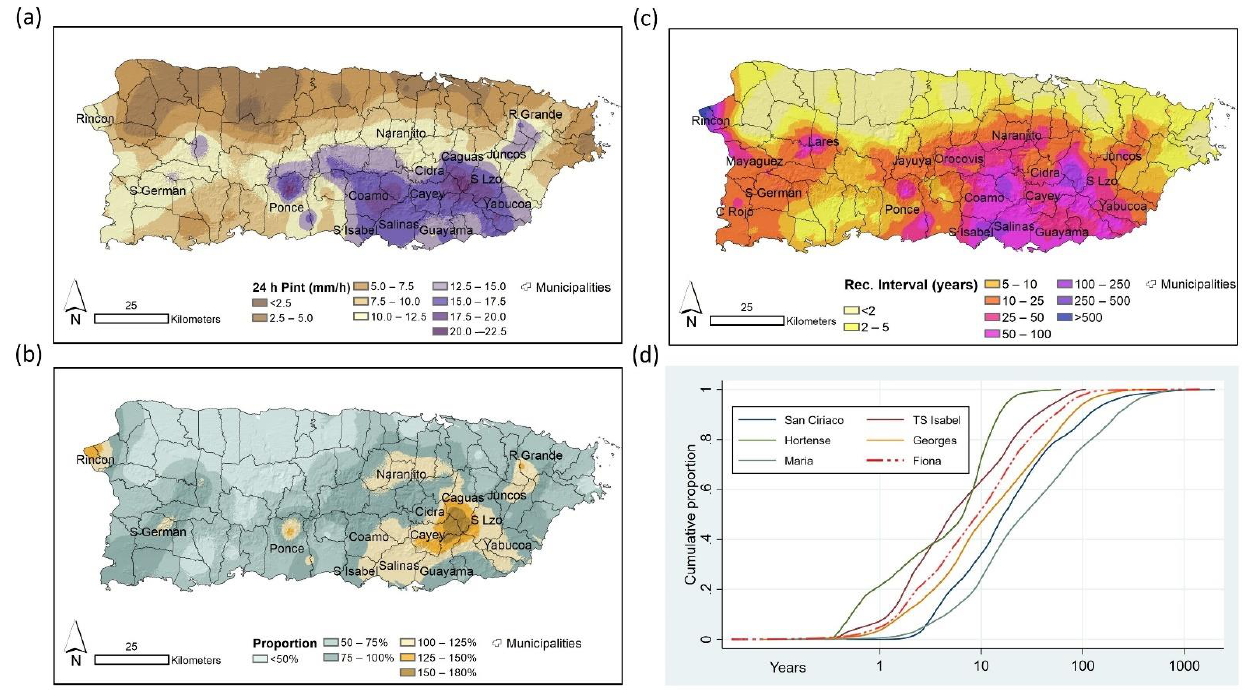
Figure 4. Hurricane Fiona’s 24 h P int characteristics. ( a ) Spatial distribution of 24 h P int in mm h −1 during Hurricane Fiona based on co-kriging analysis on data collected at 112 weather stations; ( b ) Ratio of Hurricane Fiona’s interpolated 24 h P int to the maximum for all other tropical cyclones that have affected Puerto Rico from 1899 to 2017 with the exception of Hurricane Maria; ( c ) Spatial distribution of 24 h P int recurrence interval (in years) for Hurricane Fiona; ( d ) Cumulative distribution of 24 h P int recurrence interval curves for the six tropical cyclones with the highest 24-h rain intensity values that have affected Puerto Rico from 1899 to 2017. (data for storms previous to Hurricane Fiona were taken from Ramos-Scharron and Arima [28]).